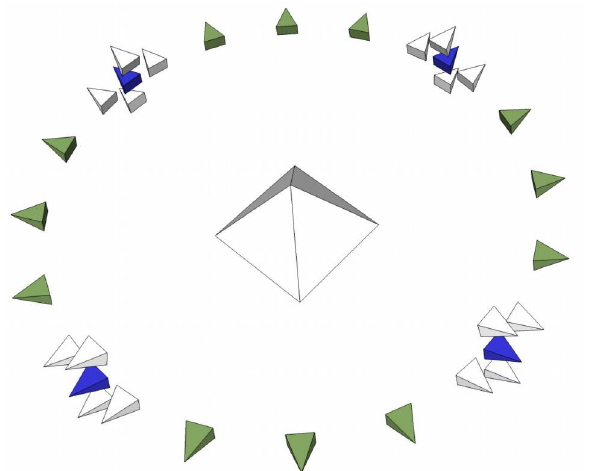
Figure 2. Spatial configuration of the acquisition of an artefact with a simple